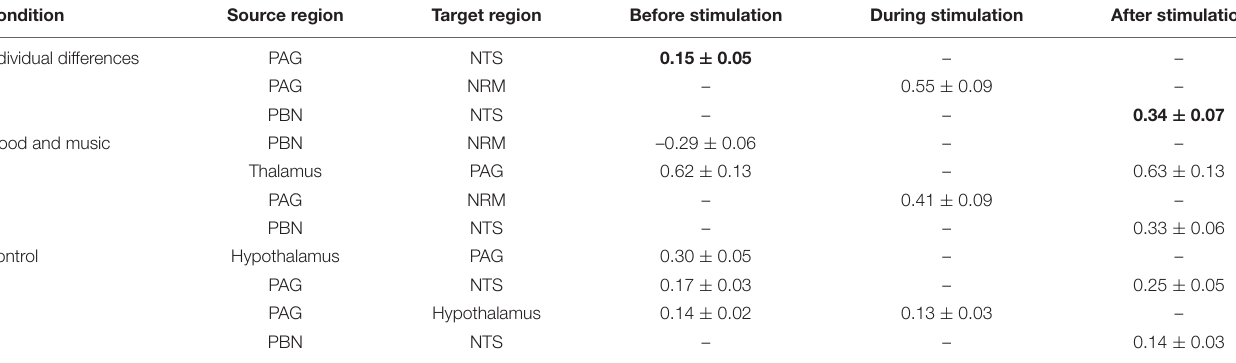
TABLE 2 | Connectivity weighting factors ( β ), calculated by SEM, that are significantly different than zero (p FWE < 0.05), bold values indicate correlation with pain ratings.